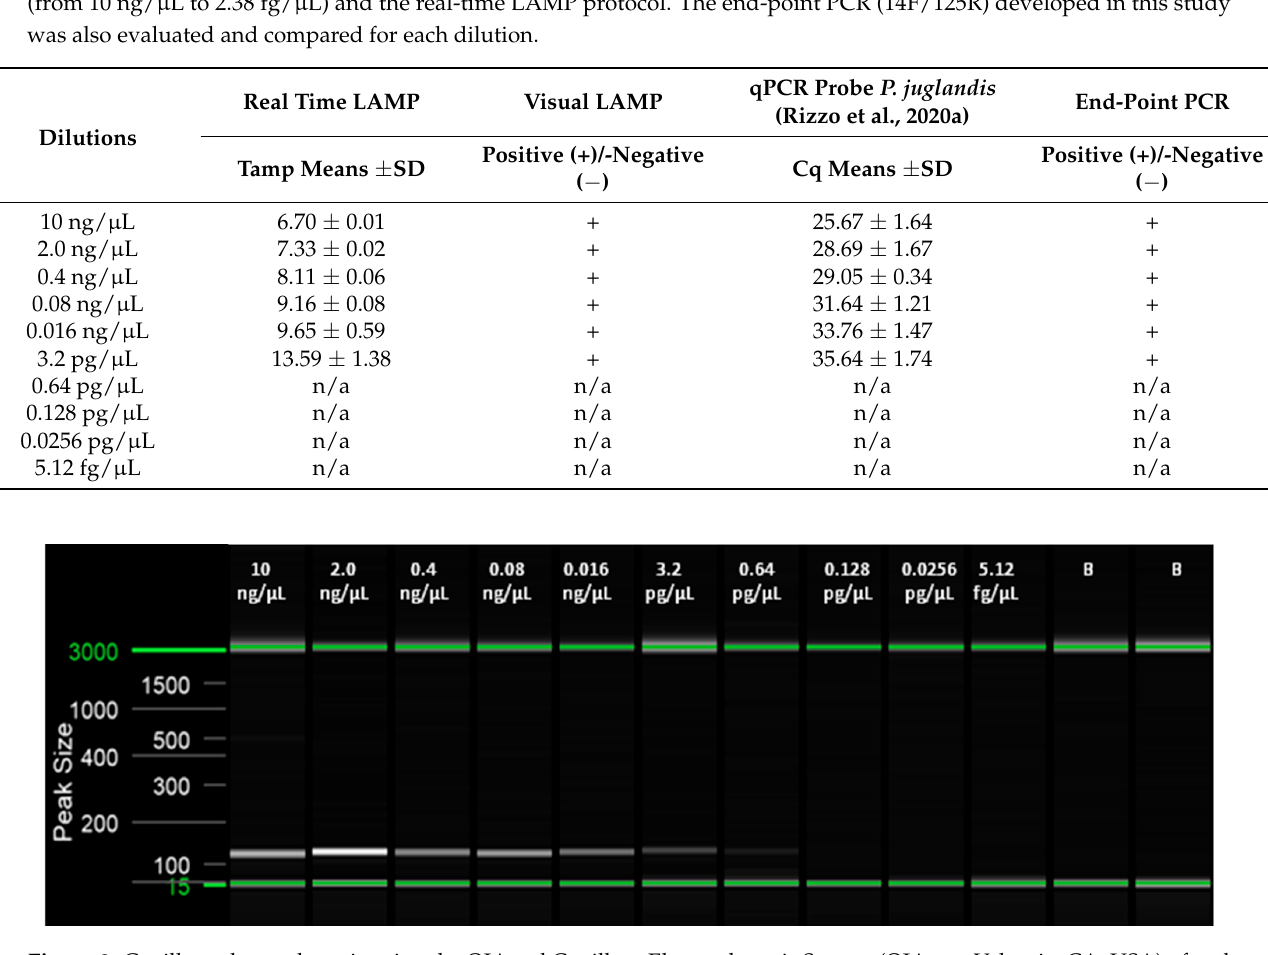
Figure 3. LoD assay of visual LAMP based on WTB adults using serial 1:5 dilutions (from 10 ng/µL to 5.12 fg/µL).